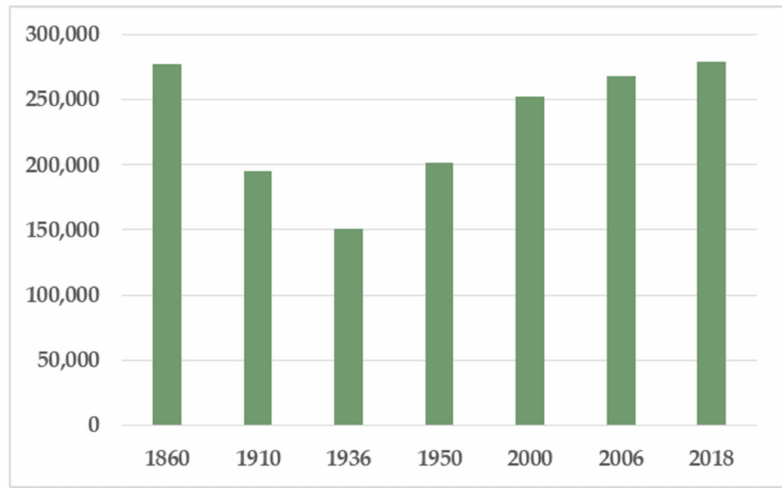
Figure 5. Bar graph of forest area (in hectares) in analysis